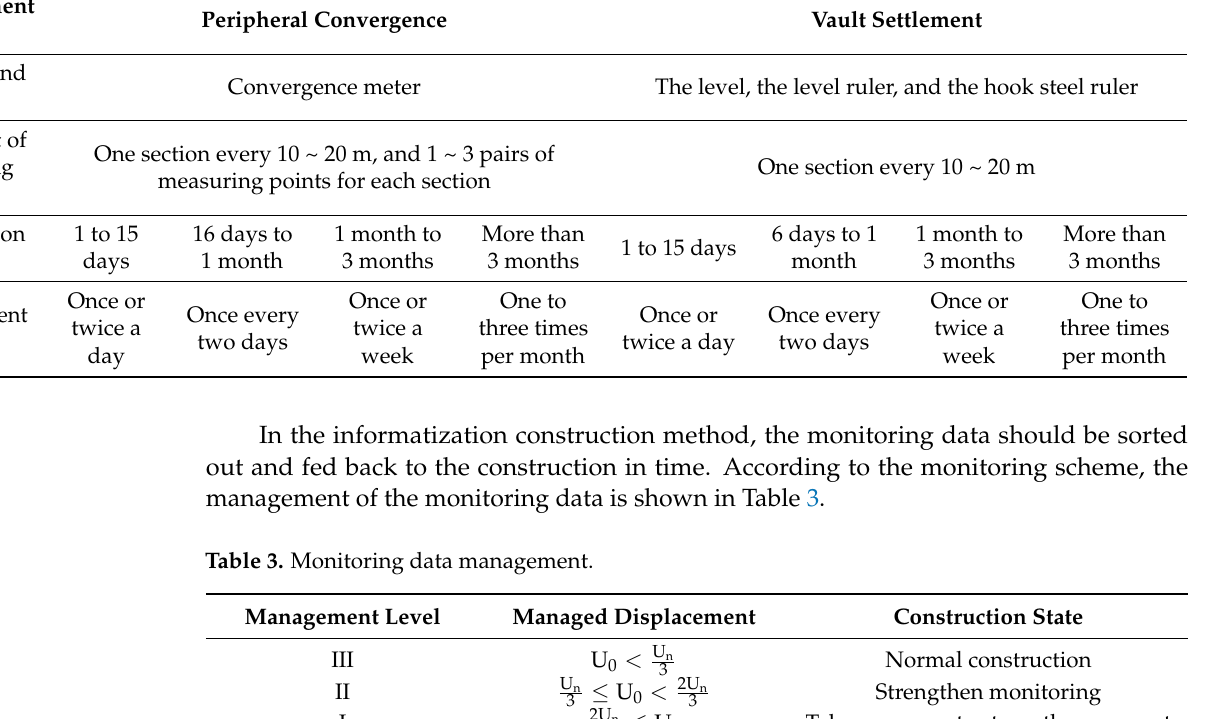
Table 2. Monitoring items and monitoring methods.